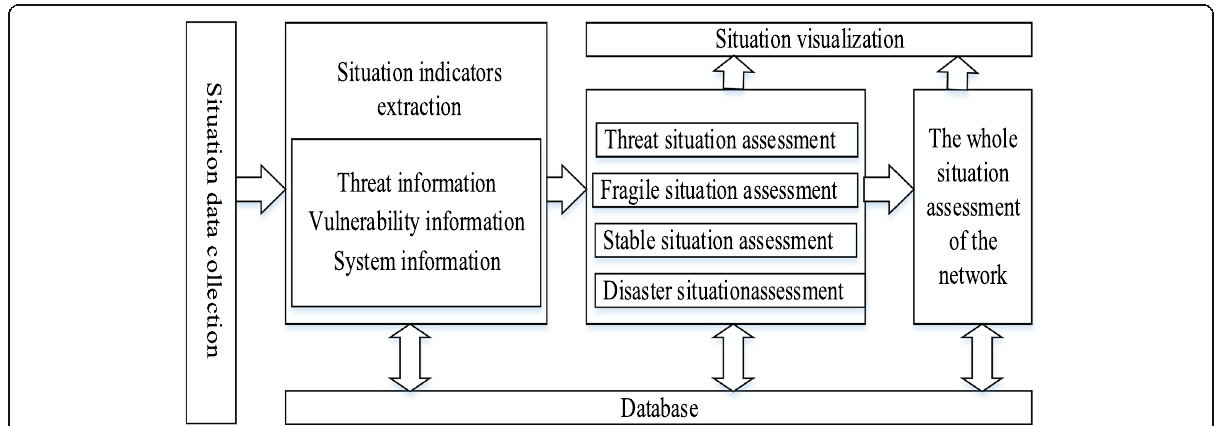
Fig. 1 Network security situation prediction model based on sequence kernel support vector